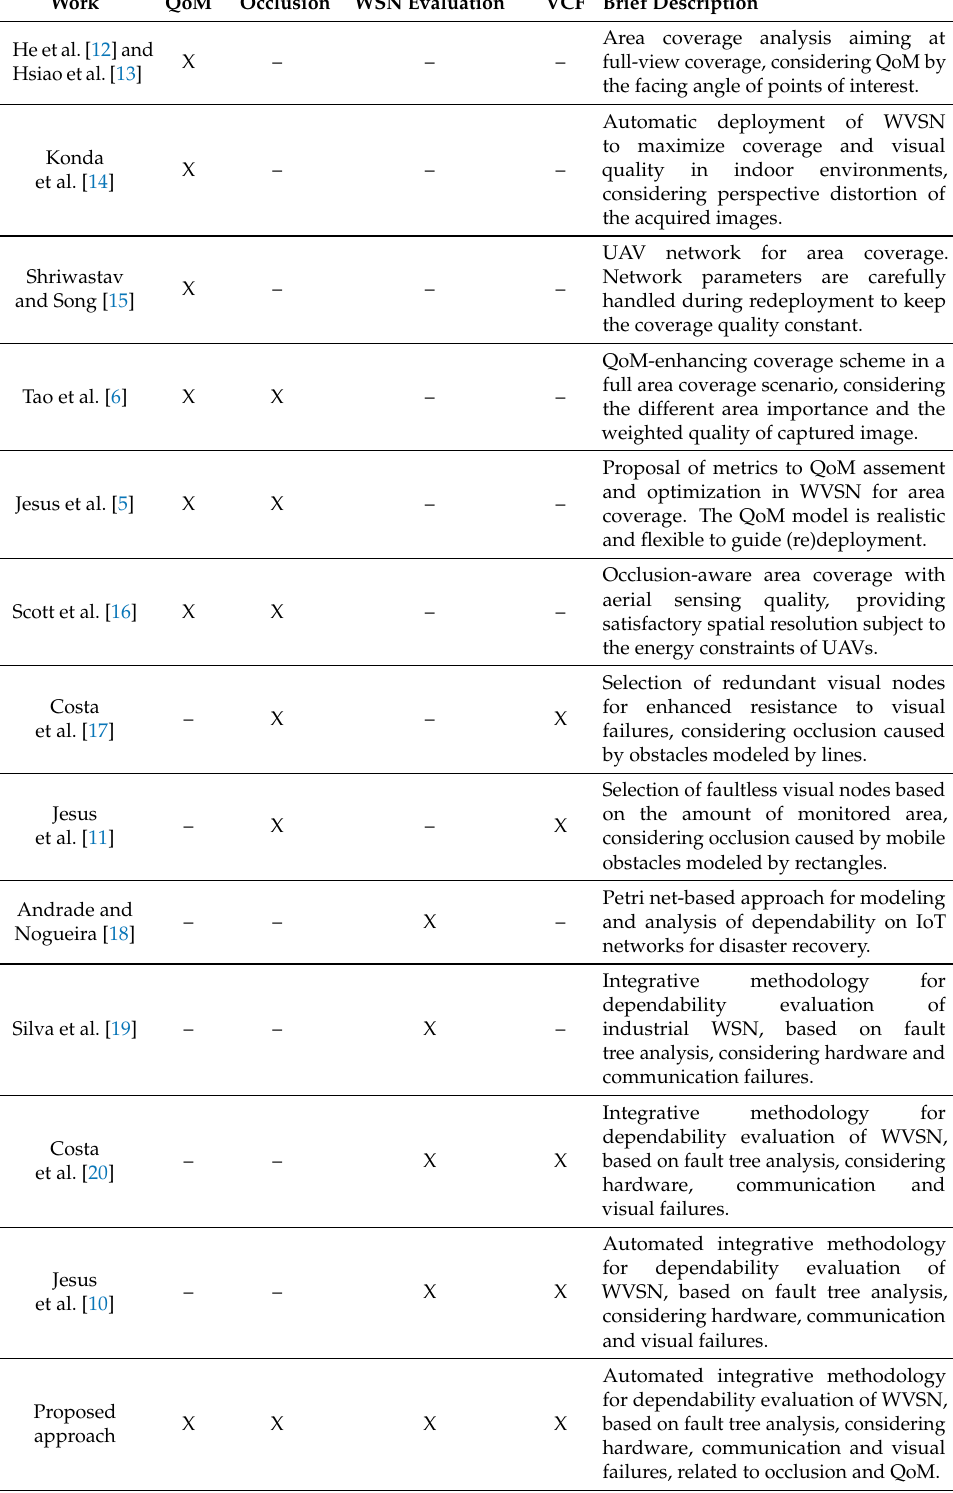
Table 1. Visual coverage research in dependability of wireless sensor